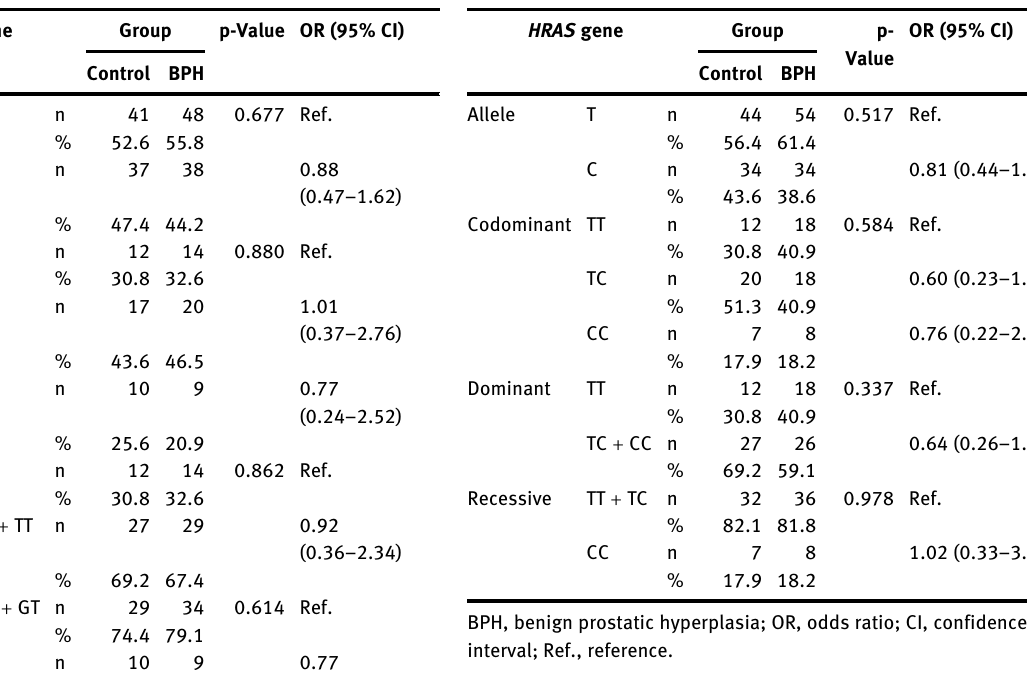
Table  : Single nucleotide polymorphism recorded in the HRAS gene (rs  ).